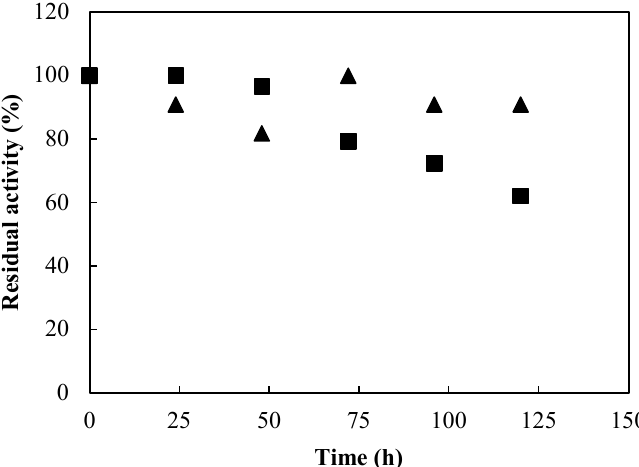
2.3. Debittering Grapefruit Juice